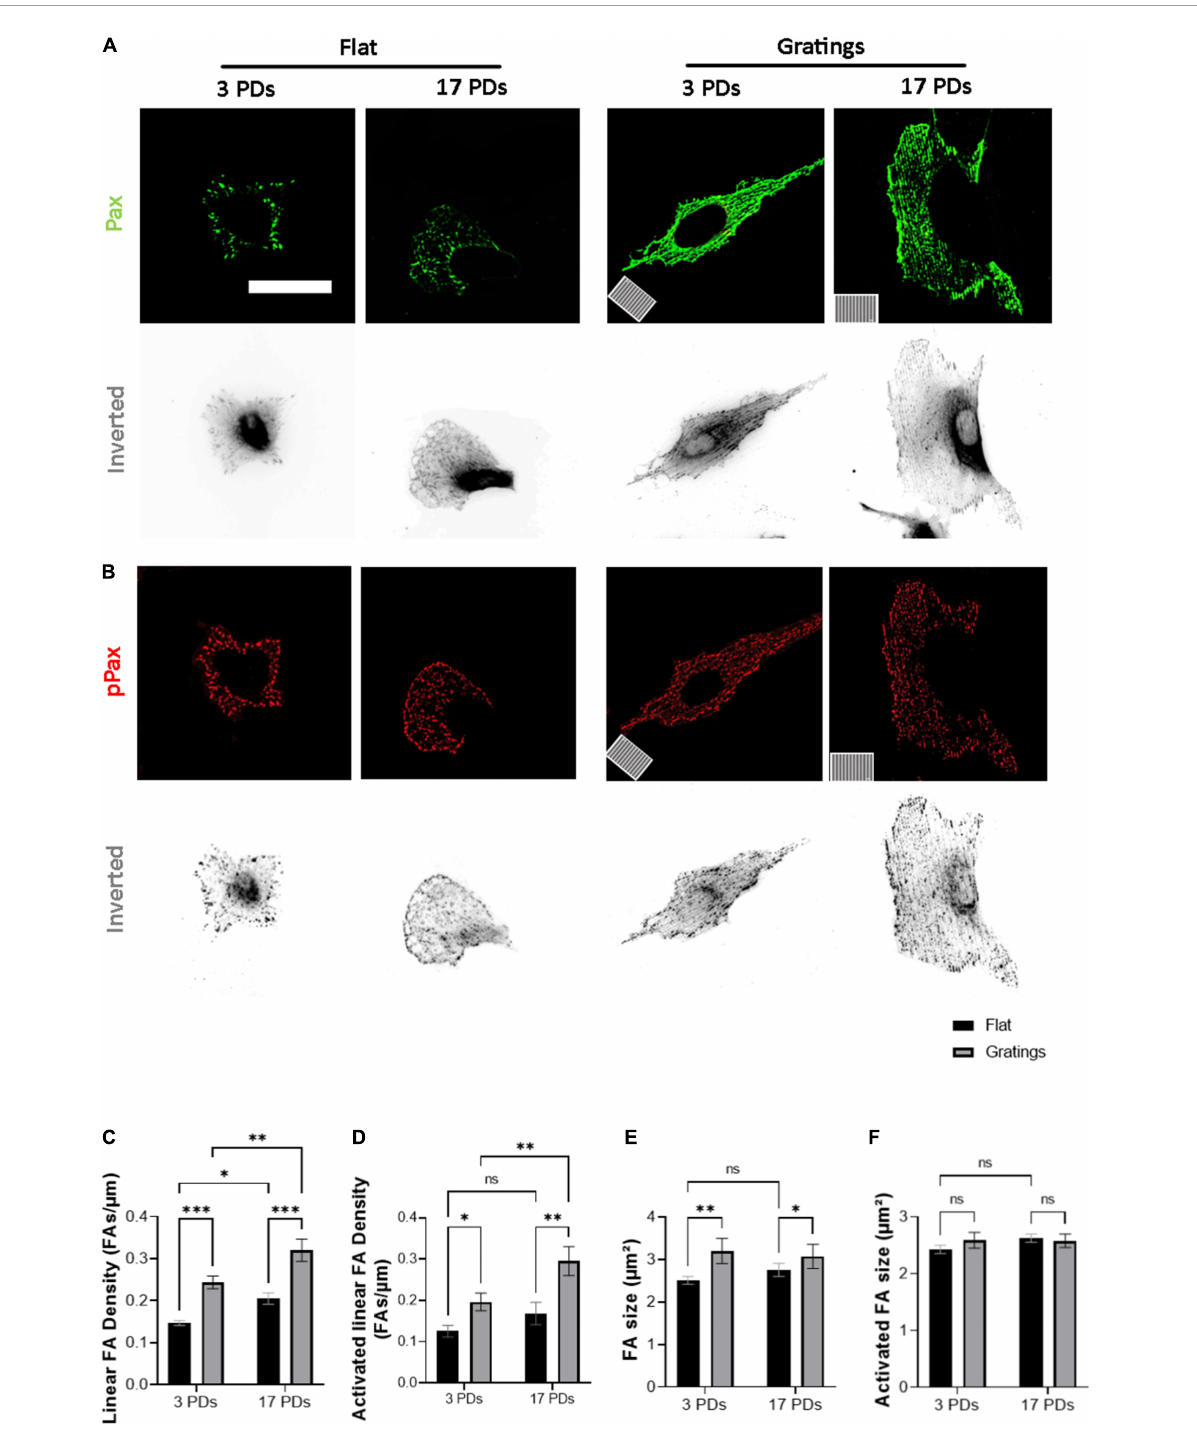
FIGURE3 Gratings enhance the establishment of FA and promote FA activation. (A,B) Representative immunofluorescence analysis of HUVECs cultured under static conditions on a flat surface and a micro-structured surface with gratings; cells were stained with (A) an antibody against paxillin (Pax, green) and (B) an antibody against phosphorylated paxillin (pPax, red). The orientation of the gratings is indicated on the panels in the lower left corner. Scale bars are 100 µ m. (C) Linear density of FA analyzed in HUVECs after 3 and 17 PDs on a flat surface and a surface with gratings. The number of FAs is normalized to the cell perimeter. (D) Linear density of activated FAs. (E) FA size after 3 and 17 PDs. (F) Activated FA size after 3 and 17 PDs. Data represent the mean and standard error of the mean of 3 donors with more than 360 FAs per condition. ∗ p < 0.05; ∗∗ p ≤ 0.01; ∗∗∗ p ≤ 0.001; ns, not